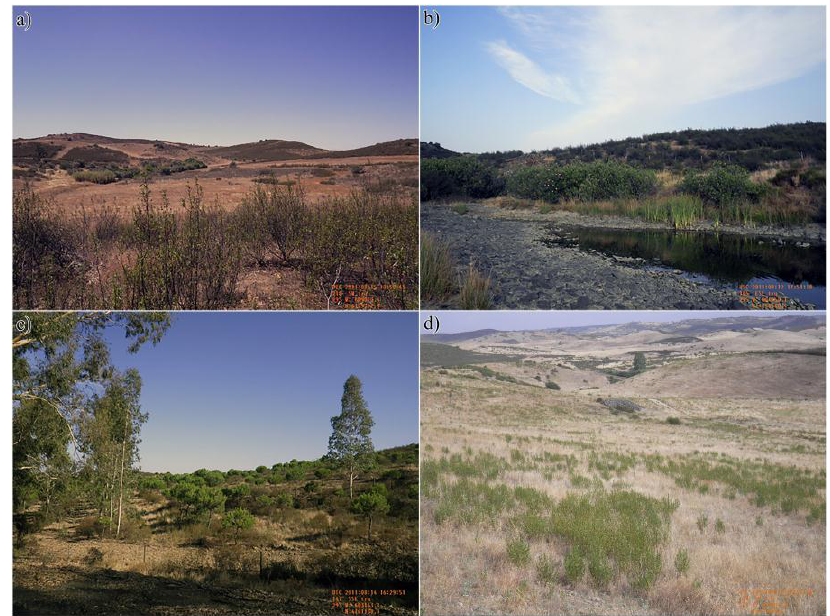
Figure 2. Photographs of shrub sites in the study area at the time of the flight campaign in August 2011. ( a ) Patches of Cistus spp . (medium/high dense) with dry and fallow grassland vegetation in the underlying background. ( b ) Riparian area with dried riverbed, Nerium oleander spp. , and Phragmites vegetation and Cistus spp. patches (high dense) at the undulating background. ( c ) Pinus pinea plantation with Cistus spp. encroachment and Eucalyptus globulus trees. ( d ) Patches of scattered small shrub plants (low/medium dense) at the slope (shrub